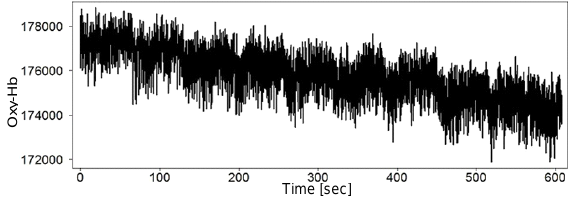
Fig. 1. Original signal from NIRS. Fig. 2. Decomposed